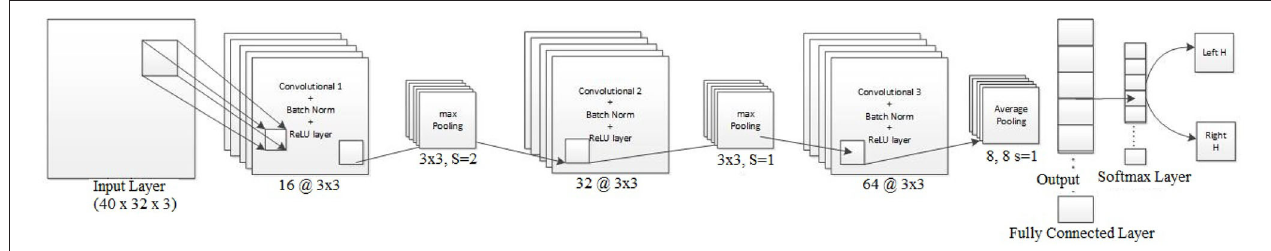
FIGURE 3 | Visualization of Architecture-1 for intra-subject classification. Lines represent the connection between the feature maps. The network starts with 3D input to the convolution which is represented as (image height, image width, and number of channels), i.e., 40 × 32 × 3, and afterward 2D convolution is performed with parameters shown in Table 1